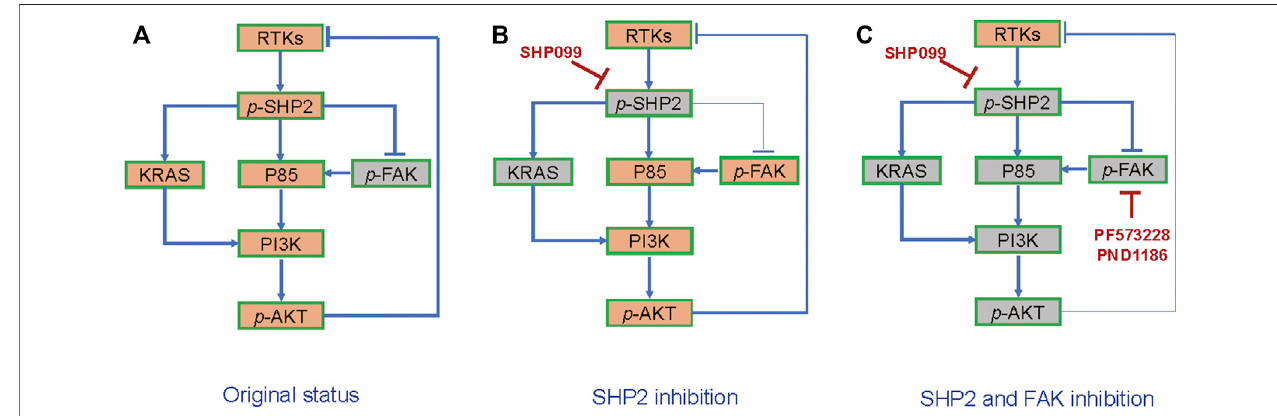
FIGURE 7 | The schematic diagram of combined suppression of SHP2/FAK-AKT signaling. (A) RTKs-SHP2 signal activates AKT but suppresses FAK. (B) FAK- AKT signal is released in response to SHP2 inhibition. (C) Combination of SHP2 and FAK blockages generates stronger AKT inhibition than the inhibitor